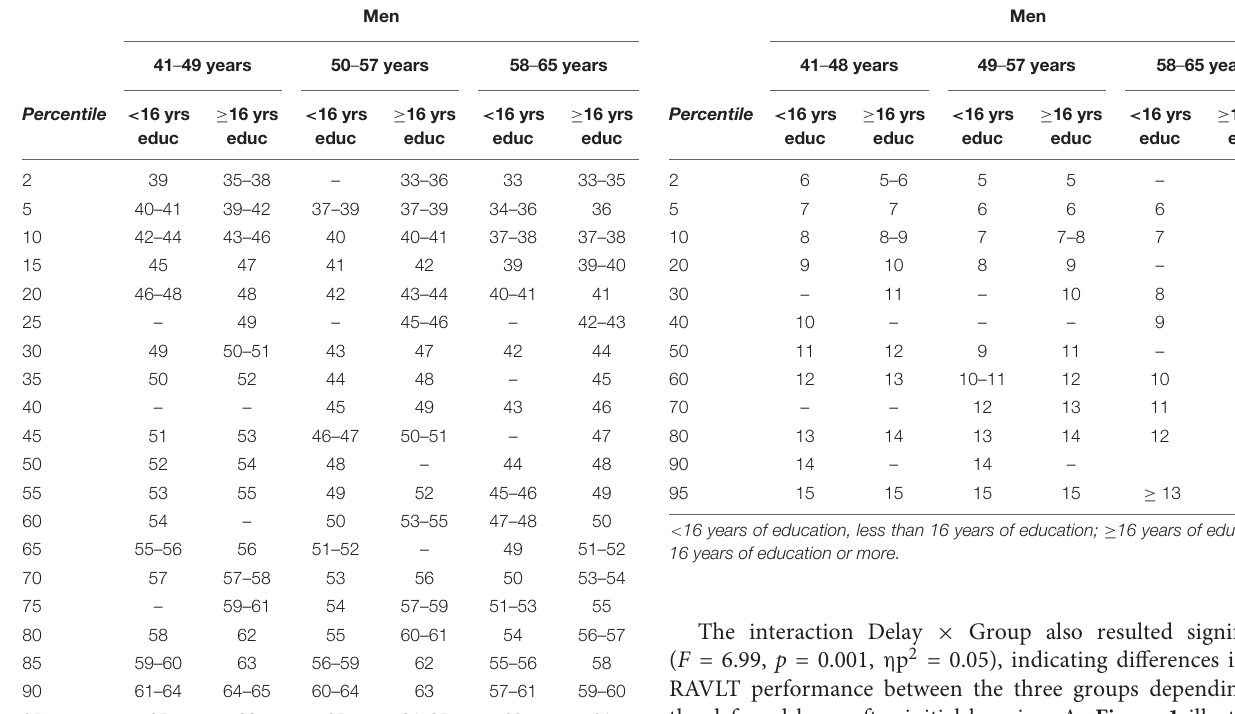
TABLE 7 | Normative data for men performance on RAVLT Immediate Total Recall.